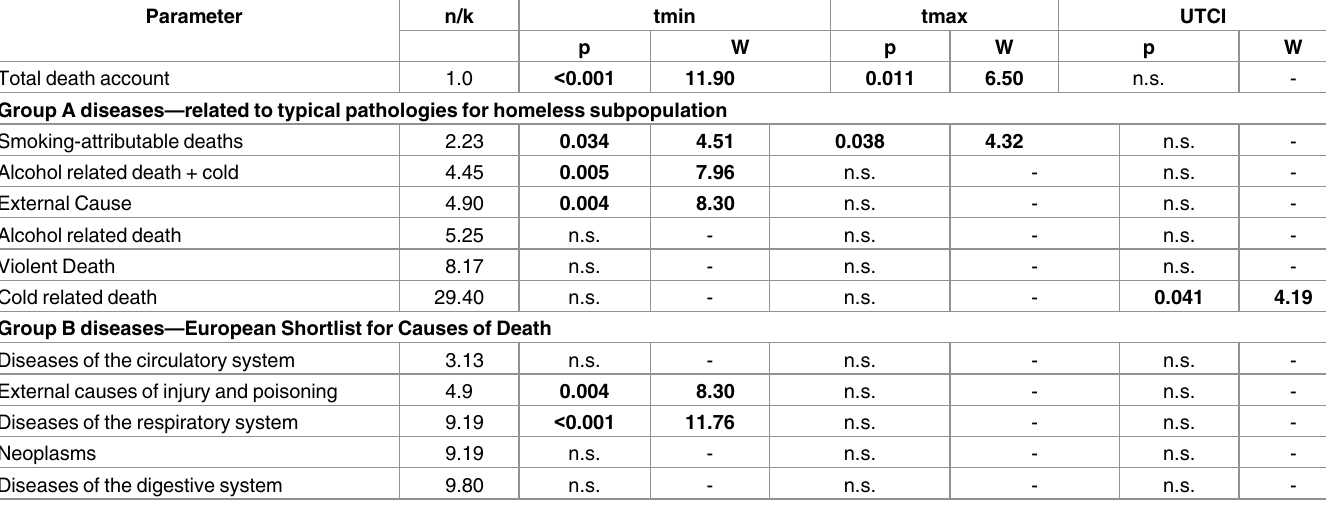
Table 5. Assessment of meteorological parameters used in the Generalized Linear Model (GLM) assuming the Poisson distribution with log link. Parameter